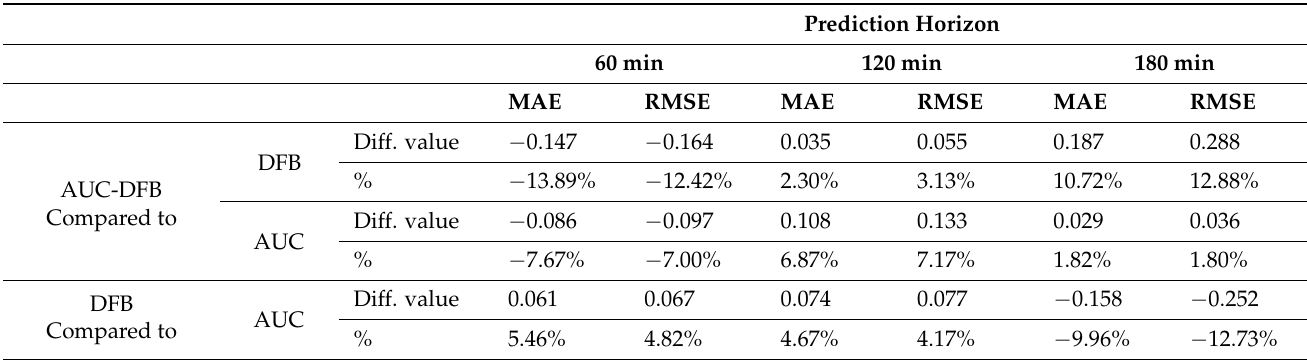
Table 9 compares the performance of the AUC-DFB model to the variations in AUC and DFB to assess the effect of the proposed two new parameters separately. Table 9. Differences between the performance of model variations. A negative difference means that the error increased. All values are in mmol/L.